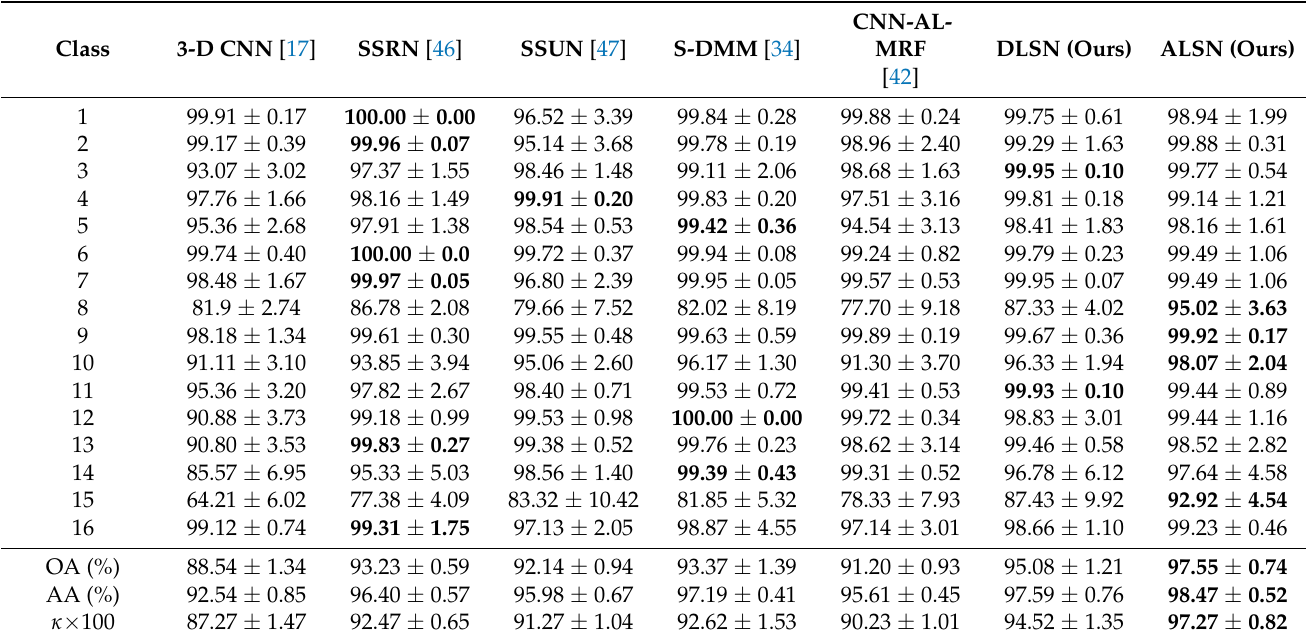
Table 6. Classification accuracy (%) for Salinas dataset (9 iterations for AL methods and 19 labeled samples per class for other